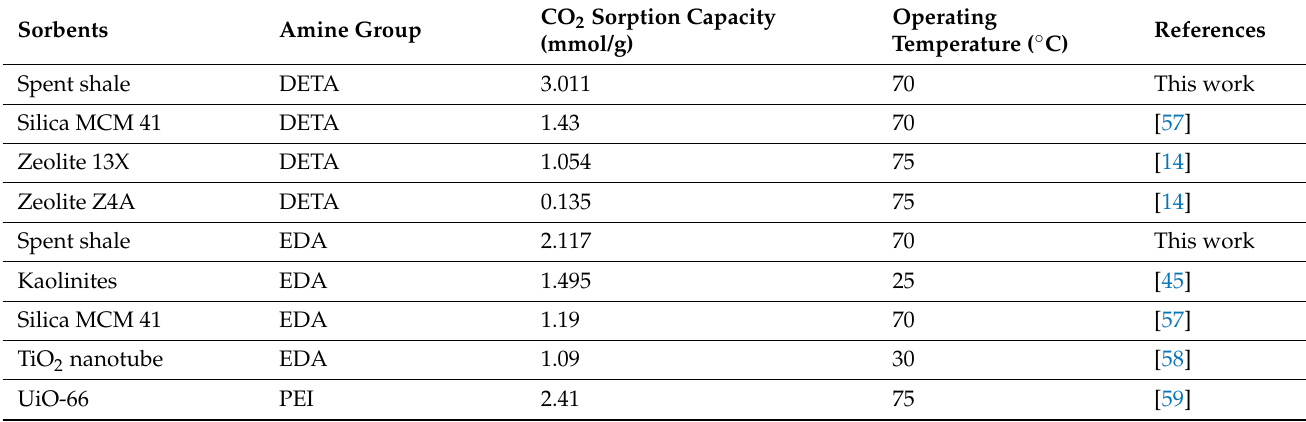
Table 4. Comparison with other amine-modified sorbents for CO 2